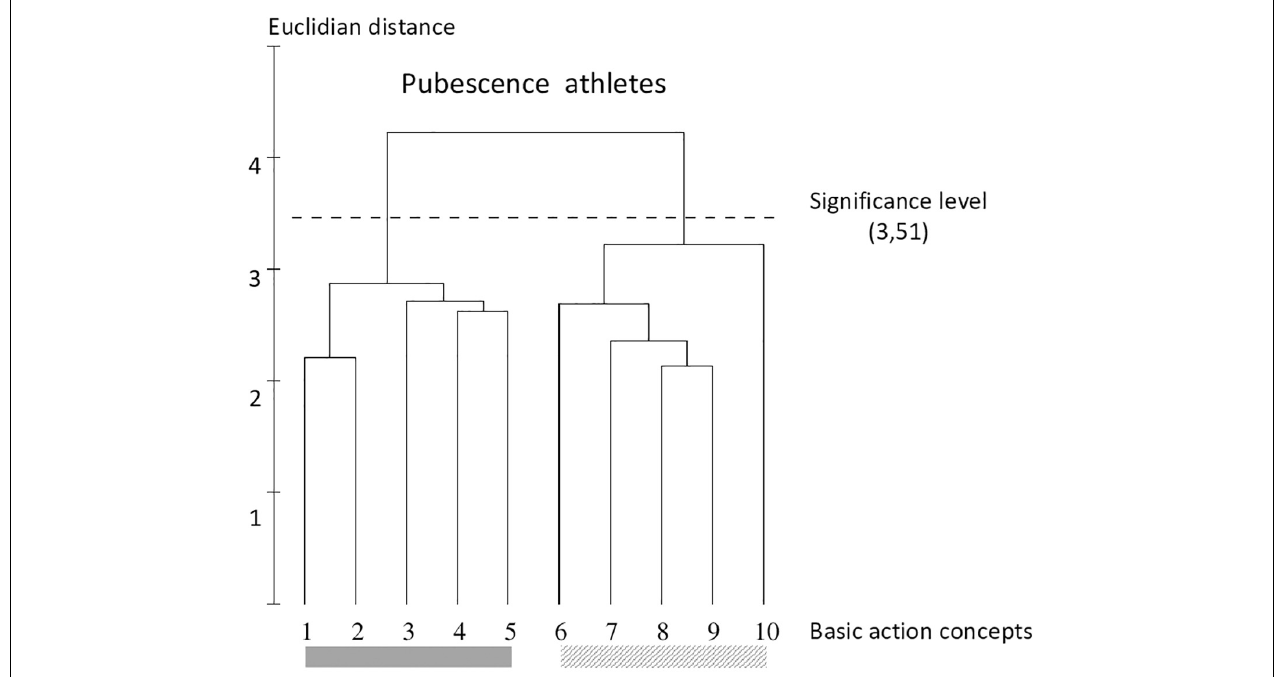
FIGURE 6 | Outcome of the hierarchical cluster analysis of athletes within pubescence ( N = 24) displayed as a dendrogram. The dashed line clarifies the critical value of d crit = 3.51, which corresponds to a significance level of 5%. The BACs are marked with numbers among the dendrogram and highlighted with the gray solid bar (technically correct BAC) and diagonally striped bar (faulty BAC).